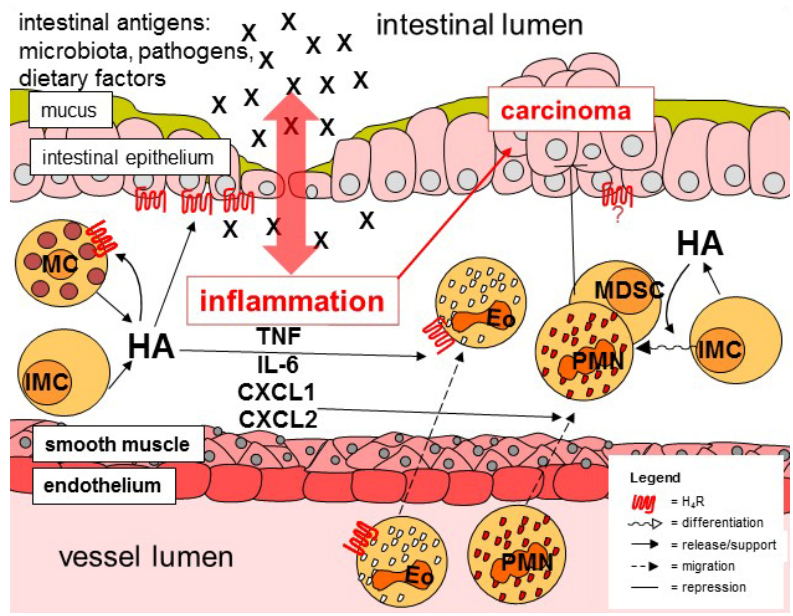
Figure 1. Schematic representation of inflammatory and carcinogenic mechanisms in the colon. MC, mast cell; IMC, immature myeloid cell; HA, histamine; Eo, eosinophil; PMN, neutrophil; MDSC, myeloid-derived suppressor cells.